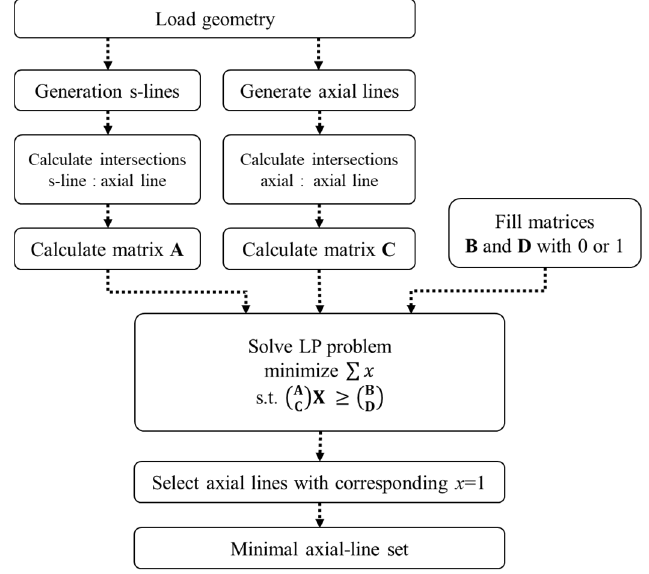
Figure 3. A minimal set of axial lines that “get everywhere” ( n = 11, isolated lines suppressed).